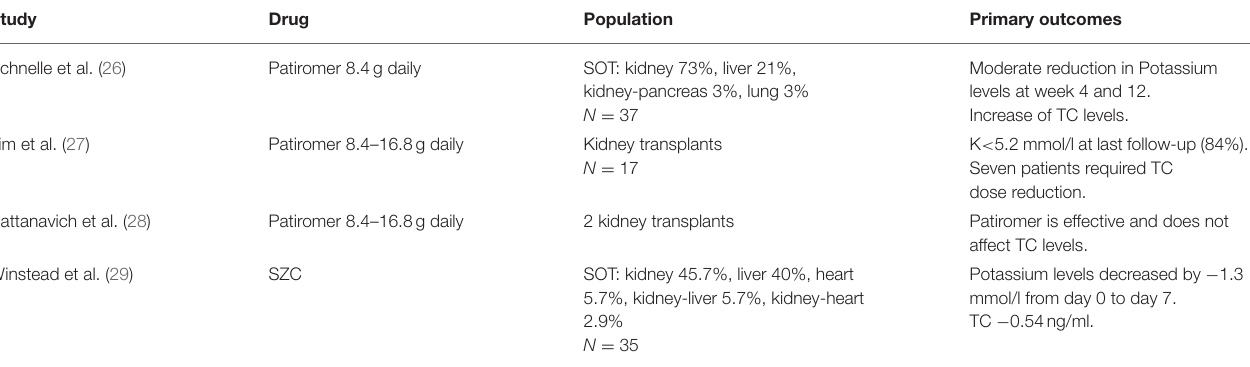
TABLE 1 | Clinical studies of Patiromer and SZC in transplant patients.